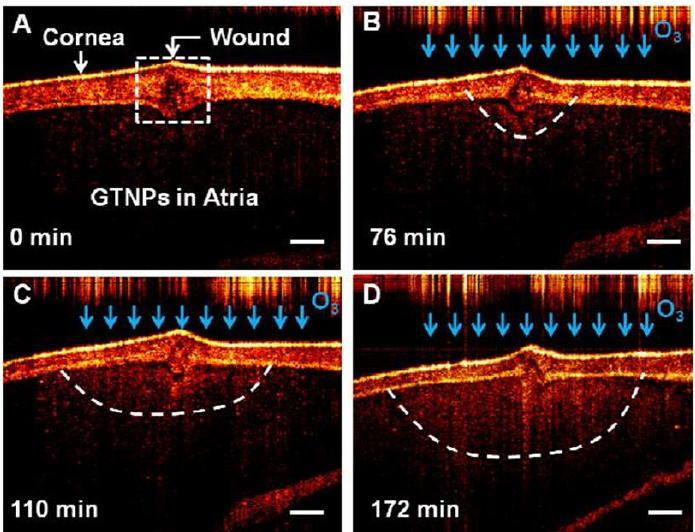
Figure 3. Images of an isolated crucian carp eye after the AuTNP injection under ozone exposure: 0 min ( A ), 76 min ( B ), 110 min ( C ), and 172 min ( D ). The scale bars represent 300 µm. Reprinted with permission from X. Jiang, P. Tang, P. Gao, Y. S. Zhang, C. Yi, and J. Zhou, “Gold Nanoprobe -Enabled